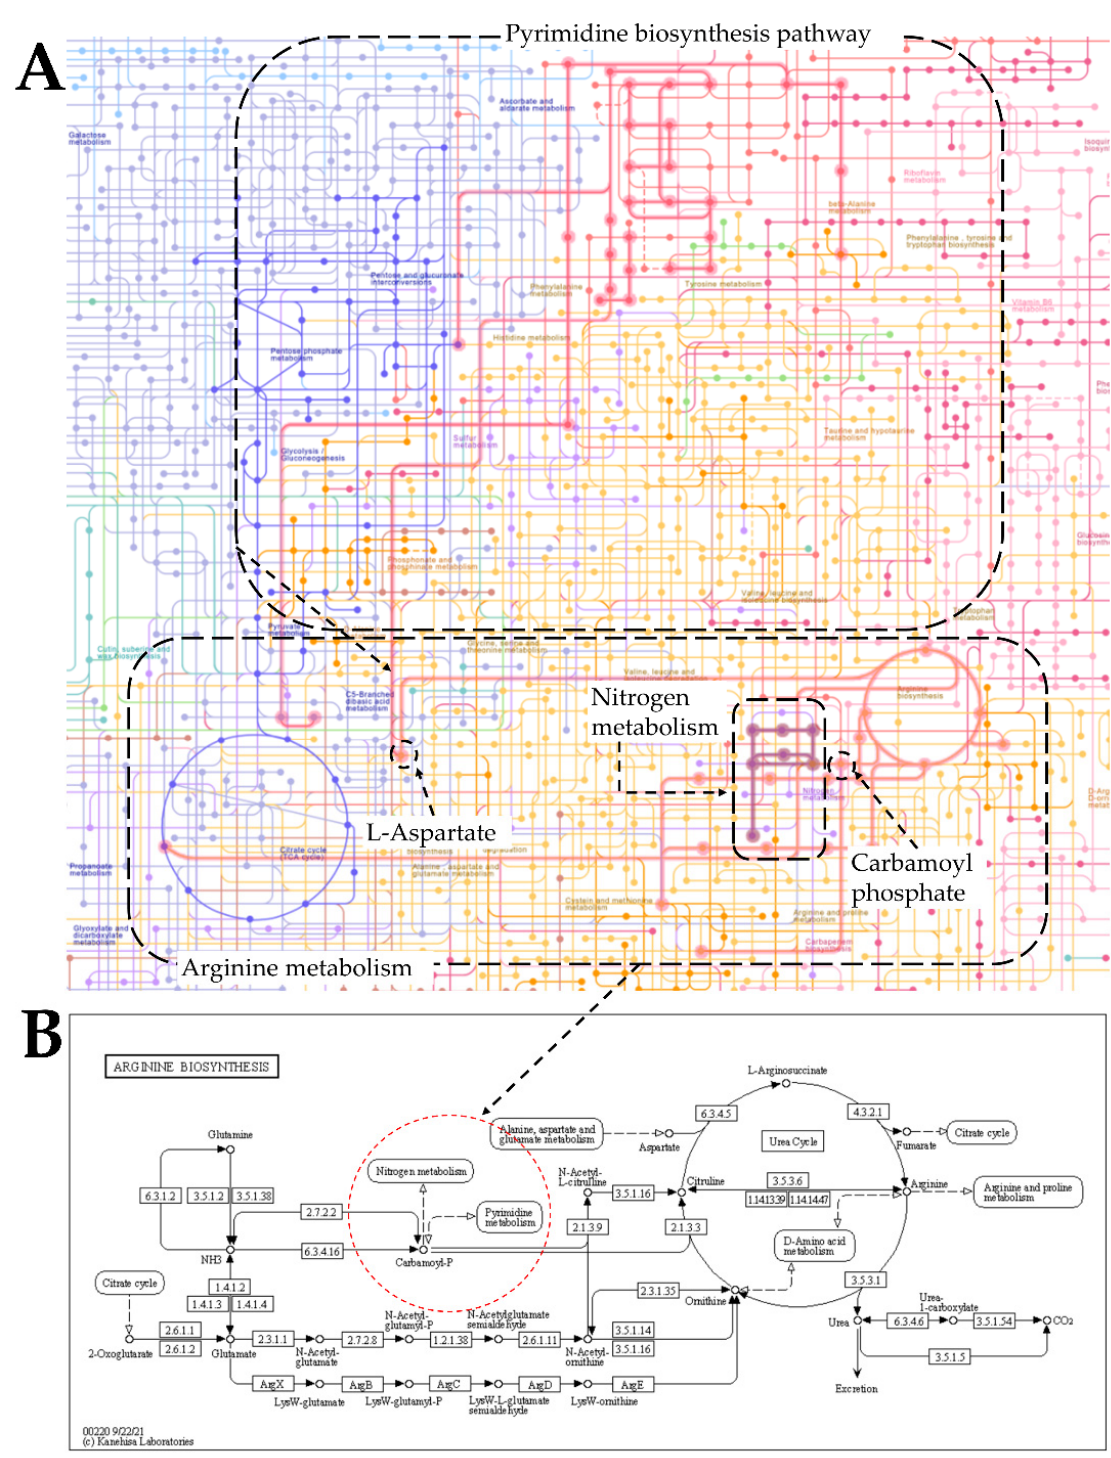
Figure 2. Interplay between pyrimidine, arginine nitrogen metabolism. ( A ) Shows Carbamoyl phosphate as the major substrate linking the pyrimidine pathway, arginine pathway and the nitrogen metabolism. ( B ) Displays the Arginine biosynthesis pathway highlighting the crosstalk between nitrogen metabolism and pyrimidine biosynthesis pathway (see dotted read circle). We generated this metabolic pathway using the Kyoto Encyclopedia of Genes and Genomes (KEGG) database (https://www.genome.jp/pathway/map01100+M00052, accessed on 11 September